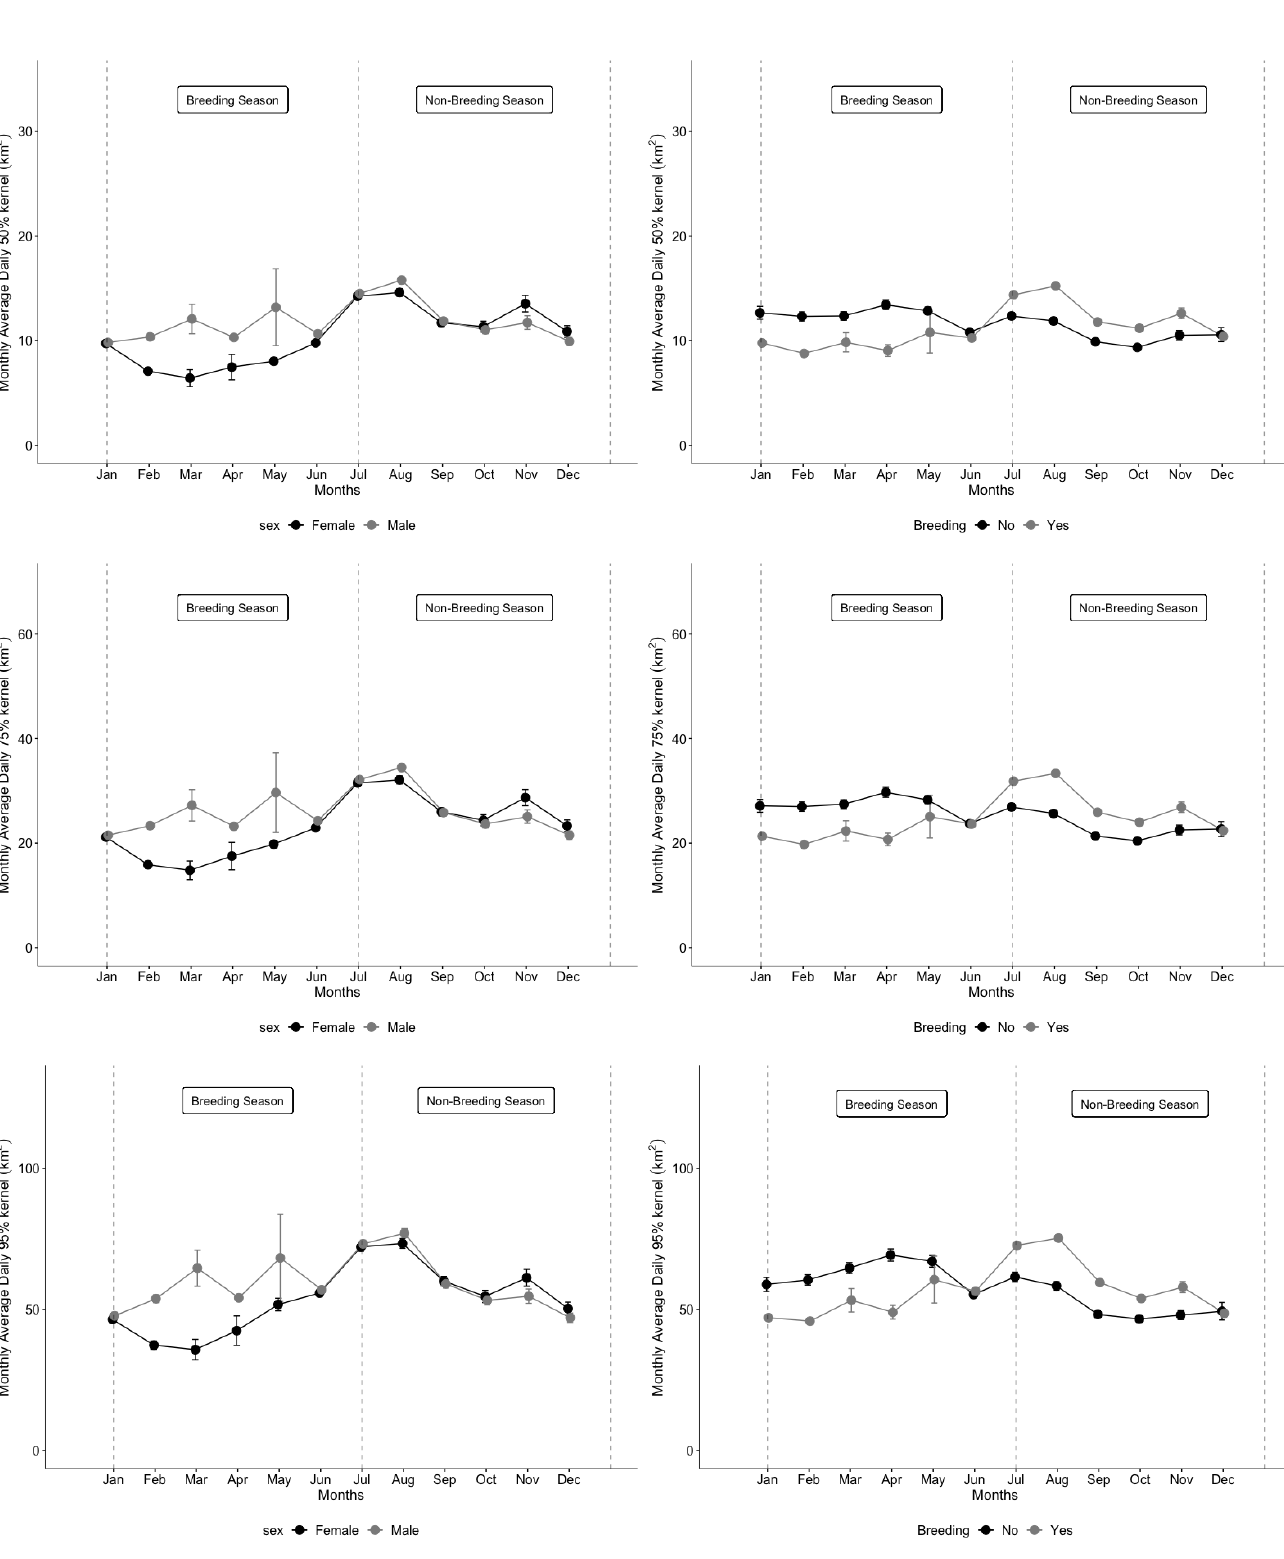
Figure 2. Seasonal differences between sexes ( left ) and breeding status ( right ) in the monthly average of daily home-range size (K95%, K75%, and K50%) over the year. Vertical dashed black lines delimitate the different seasons.